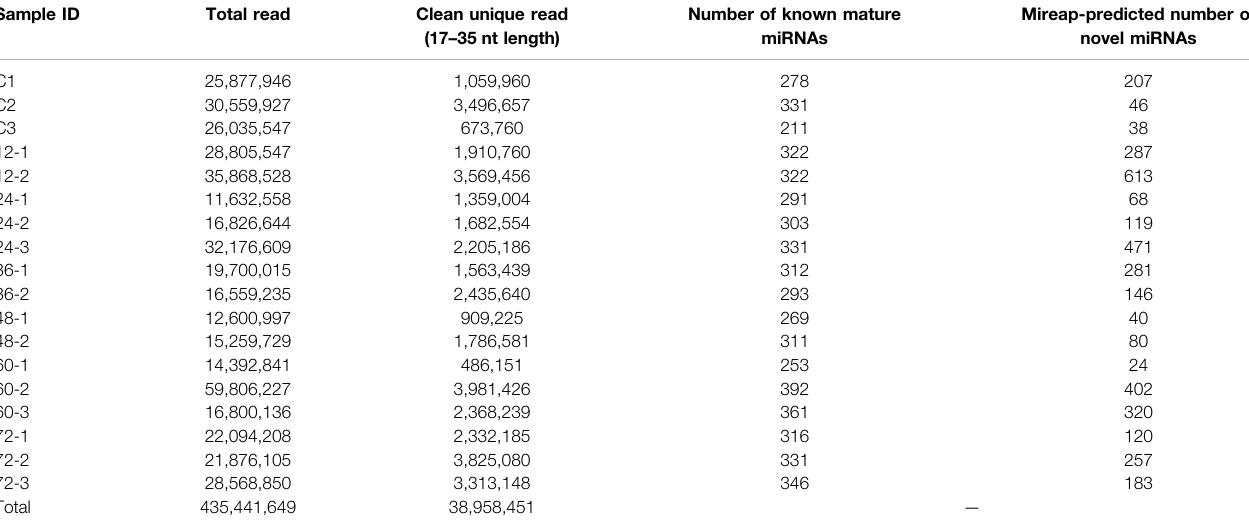
TABLE 1 | sRNA-sequencing data statistics. The total number of raw reads and clean unique reads after quality fi ltration are listed for each sequencing dataset. The total number of known miRNAs and Mireap-predicted novel miRNAs for each dataset are shown in the table. Sample